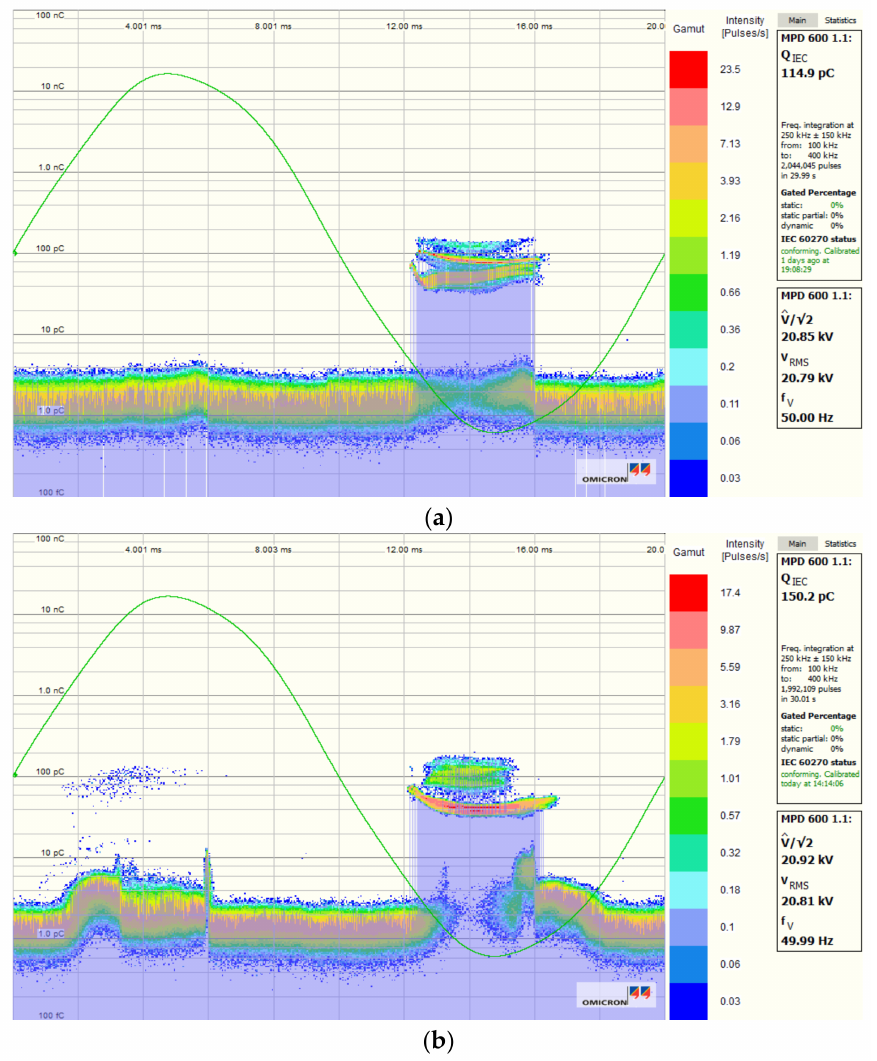
Figure 15. PD measurement results of sample D: ( a ) before and ( b ) after the 39th